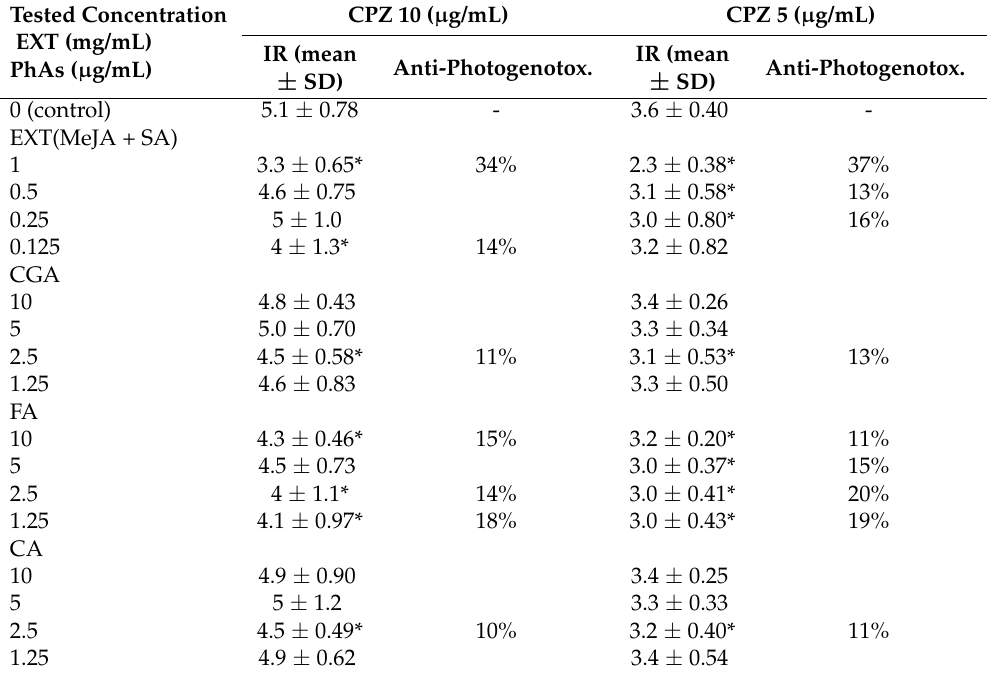
Table 7. Evaluation of anti-photogenotoxic activity based on IR values for the control—photogenotoxin chlorpromazine (CPZ)—and the mixture of CPZ with EXT(MeJA + SA) and PhAs. Tested